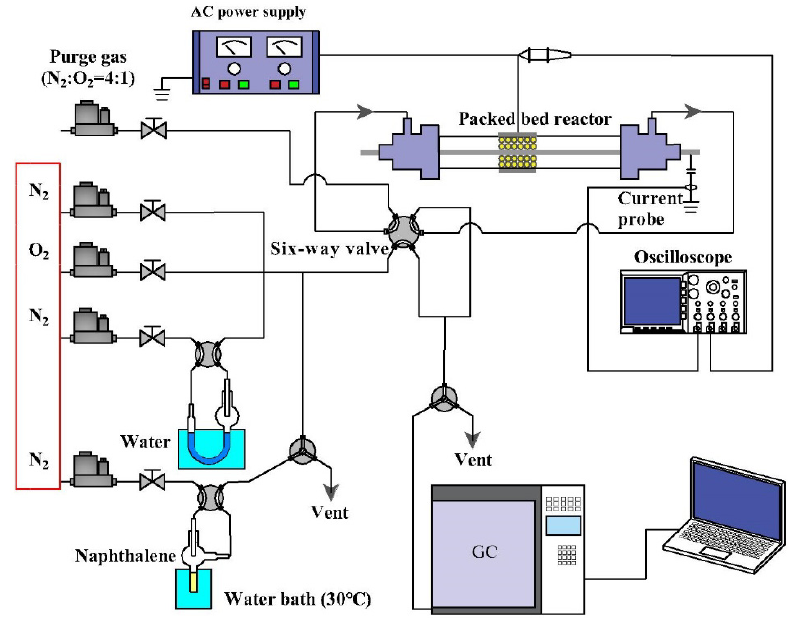
Figure 1. Schematic diagram of the experimental setup.